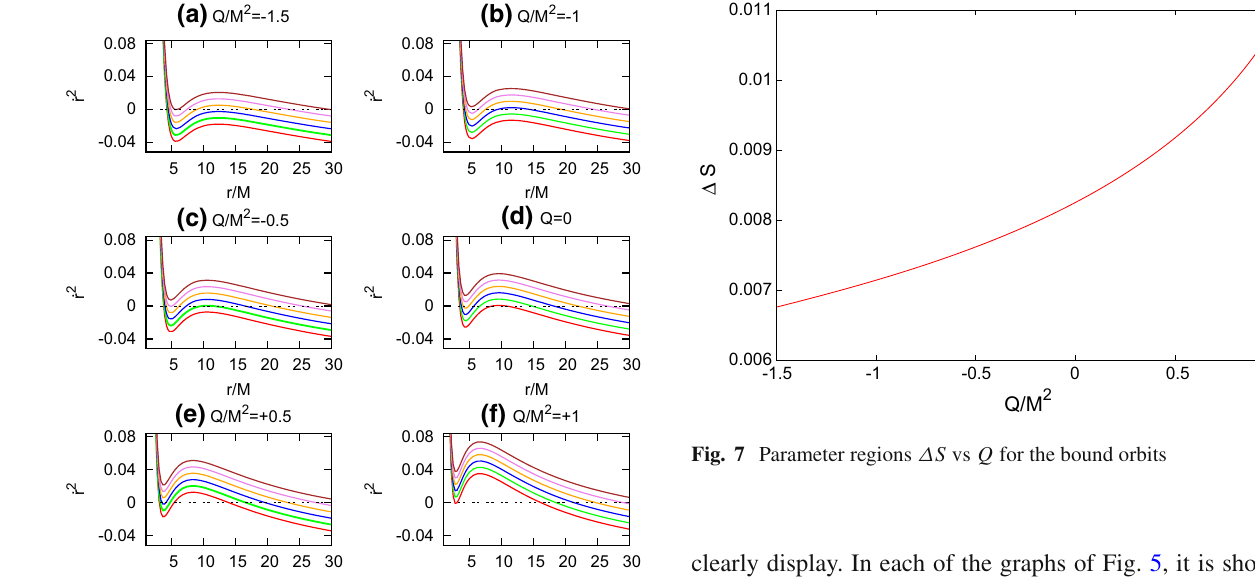
clearly display. In each of the graphs of Fig. 5, it is shown that these curves have a sharp decrease firstly, then increase and slowly decrease with r later. Each curve in Fig. 5 has two extremal points. The bound orbits between ISCO and MBO we take into account only belong to these curves in which two extremal points have the opposite signs. For instance, the blue line meets this condition when Q = − 0 . 5 M 2 , where one extremal point is negative while the other is